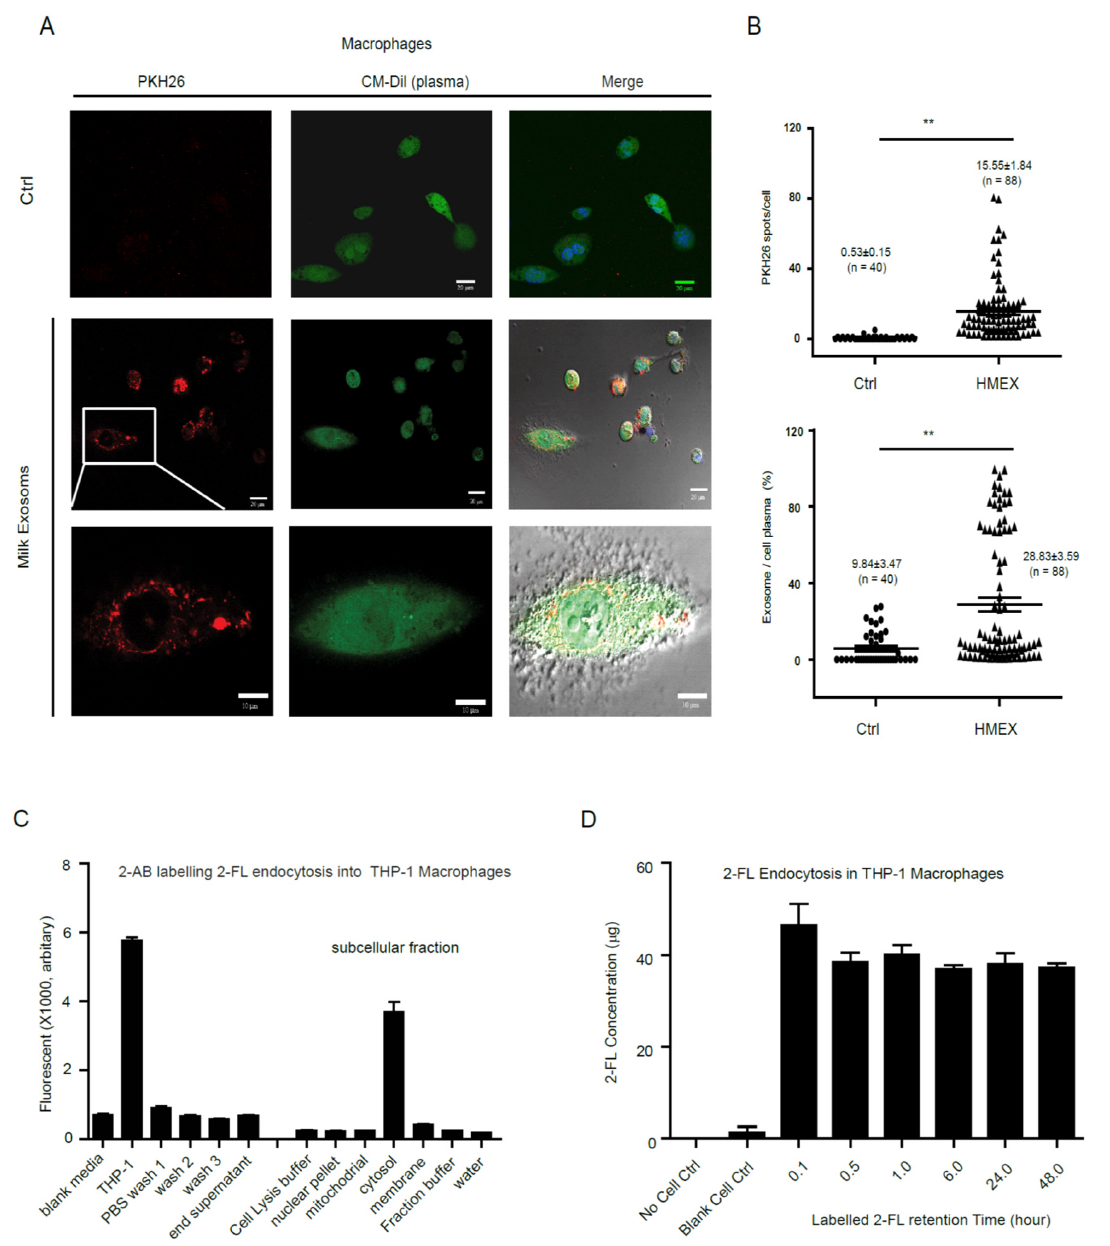
Figure 3. Human milk exosomes endocytosis into cytosol of macrophages. Isolated milk exosomes were labeled with PKH26 (from 1 mL of colostrum) and added into THP-1 differentiated macrophages at 37 °C. The macrophages cellular plasma was stained with CM-Dil and cells were dynamic tracking by fluorescence microscopy ( A ). The 2-AB labeled 2 (cid:48) -FL mainly distributed in the cytosol fraction of macrophages ( B ). The 2-AB’s fluorescence intensity of 2 (cid:48) -FL distributed in the cytosol fraction of macrophages ( C ) and maintained stable over 48 h ( D ). ** p ≤